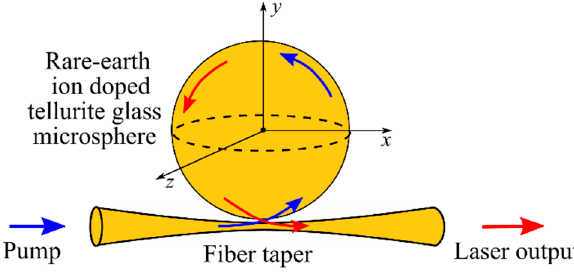
Figure 2. Variant of experimental microlaser scheme with a fiber taper used for both pump coupling and extracting the generated radiation from the microsphere.